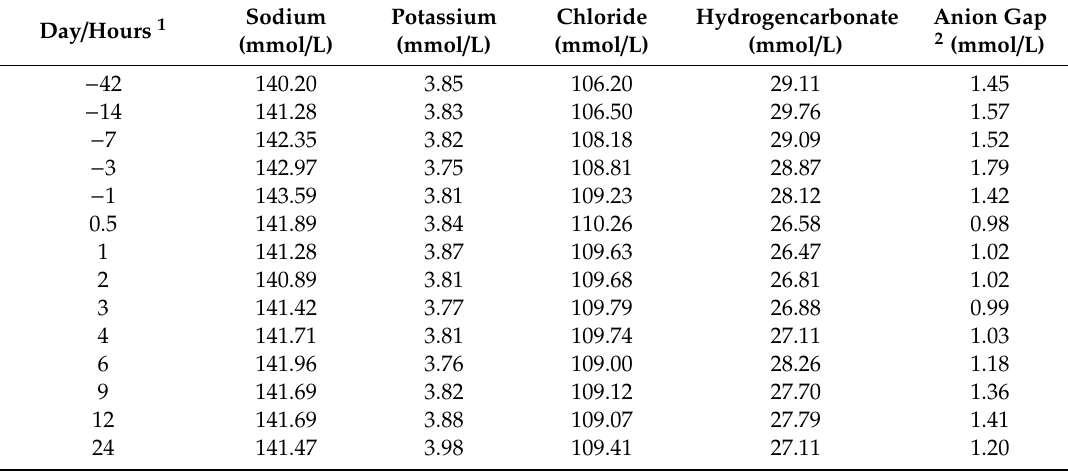
Table A5. E ff ects of L-carnitine supplementation on electrolytes in blood and on anion